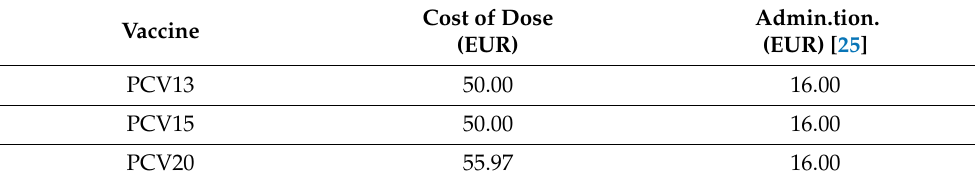
Table 5. Cost of vaccines